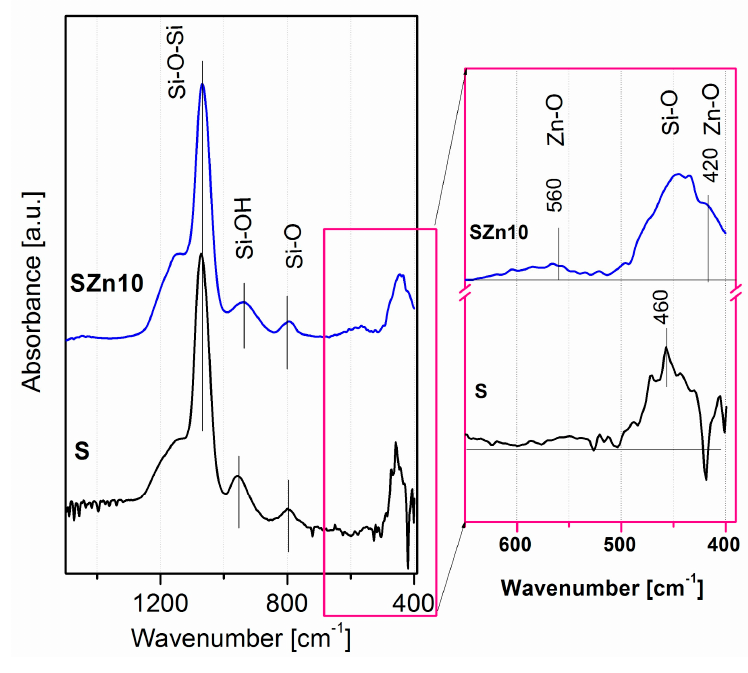
Figure 5. FTIR spectra of S and SZn10 coatings.